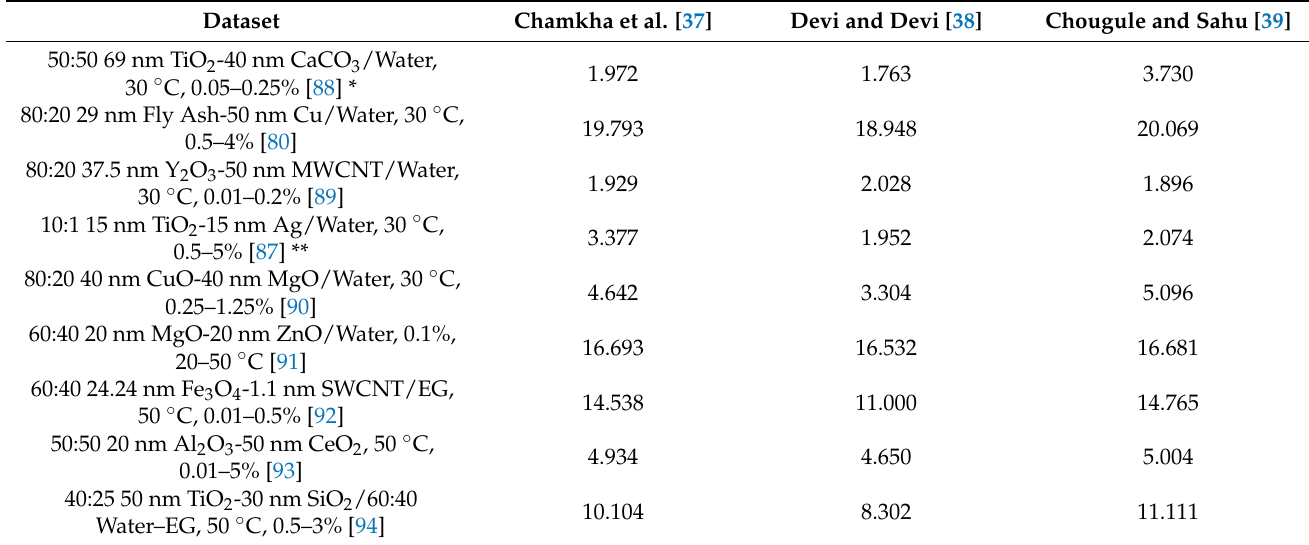
* Experimental data used in Figure 13; ** Experimental data used in Figure